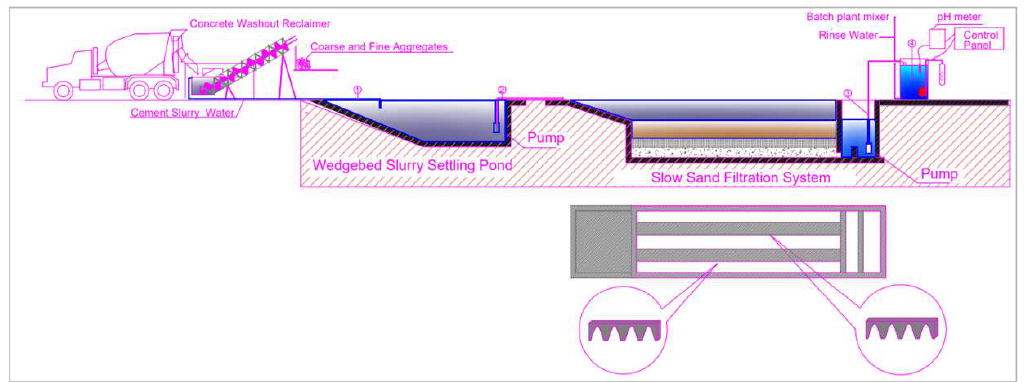
Figure 1. Schematic diagram of recycling process of concrete washout water. As represented in